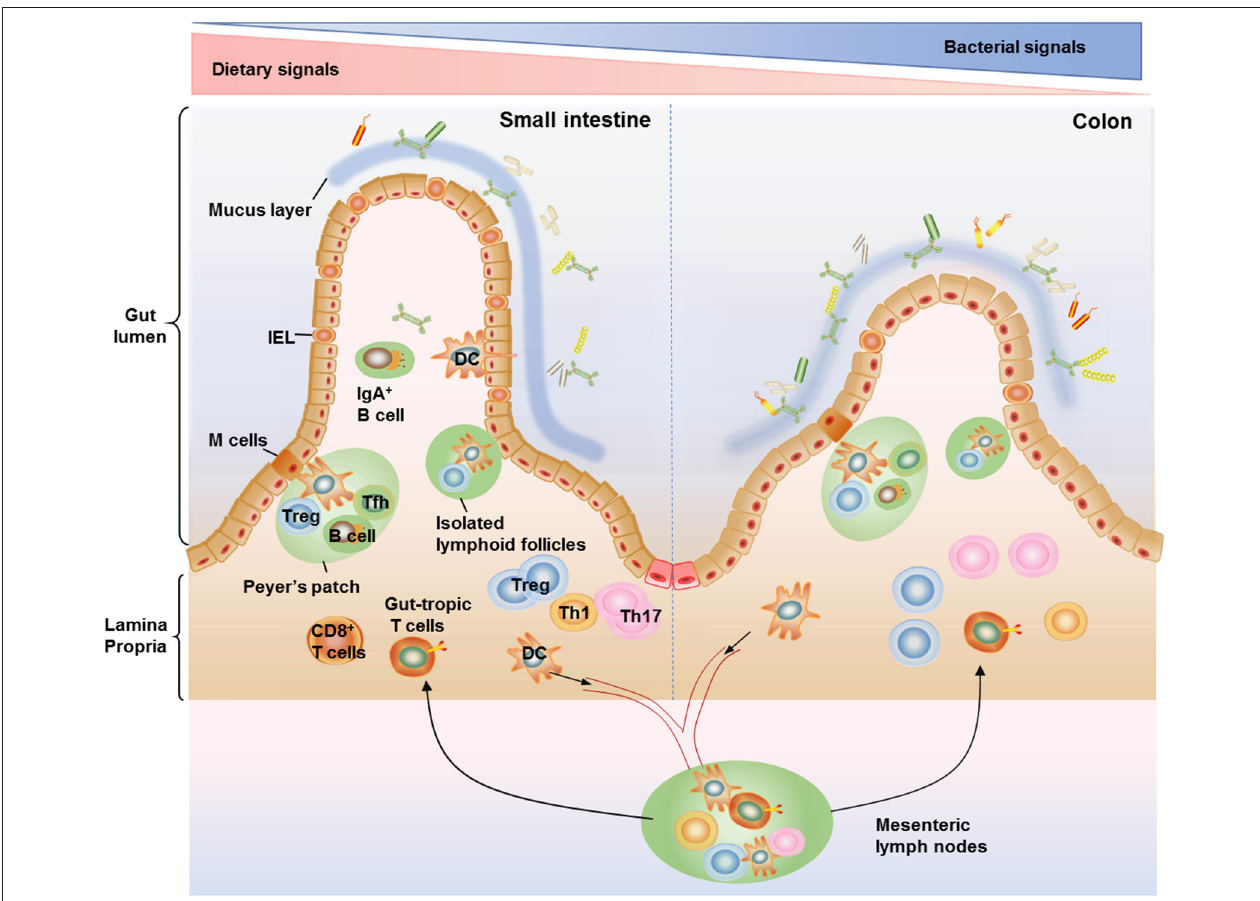
FIGURE 1 | Anatomical distribution of intestinal T cells. T cells distributed within the small and large intestine are frequently arranged within the gut-associated lymphoid tissue (GALT), which are composed of organized lymphoid tissues including mesenteric lymph nodes, Peyer’s patches, and isolated lymphoid follicles (ILFs) as well as more diffusely scattered lymphocytes including the lamina propria lymphocytes and intraepithelial lymphocytes (IELs). IELs reside within the epithelium layer and are proximity to antigens in the gut lumen, making them components of the front line of immune defense against invading pathogens. There are more IELs in the small intestine compared with the colon. The majority of T cells in lamina propria are CD4 + T cells, with only a small population of CD8 + T cells. Among the CD4 + T cell subsets, Th17 cells and Treg cells are the most abundant cells in the gut, conferring protection against fungi and maintenance of intestinal homeostasis. The organization of Peyer’s patches is comparable to that of lymph nodes, with large B cell follicles and T cell areas. Peyer’s patches are in close contact with microfold cells (M cells) located in gut epithelium which can capture and transport antigens from the lumen to antigen-presenting cells such as dendritic cells (DCs) in the underlying Peyer’s patches. DCs can also form transepithelial dendrites to directly sample luminal antigens and then emigrate to the mesenteric lymph nodes, where they activate naive T cells to induce gut-tropic T cells. The ILFs, with features similar to Peyer’s patches, are distributed along the whole intestinal tract and believed to provide a complementary system for Peyer’s